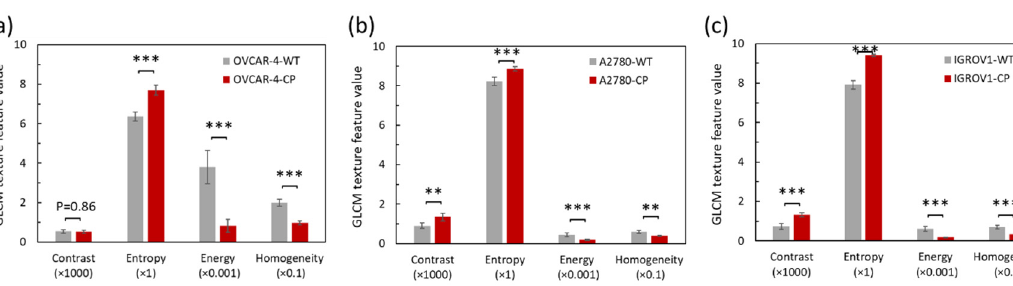
Figure 3. Gray level co-occurrence matrix (GLCM) texture feature of wild type (WT) and cisplatin (CP)-resistant ovarian adenocarcinoma cells for ( a ) OVCAR-4, ( b ) A2780, and ( c ) IGROV1.